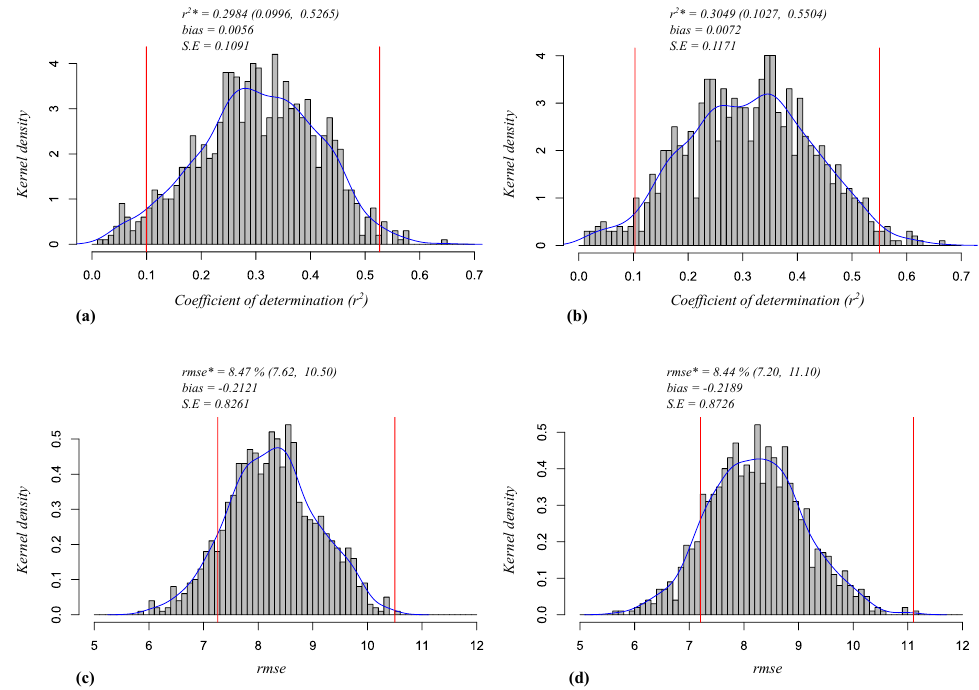
Figure 9. Bootstrap regression model performance based on 1000 bootstrap samples: ( a , b ) Histogram of the bootstrap coefficient of determination for model A and B, respectively. ( c , d ) Histogram of the bootstrap RMSE for model A and B, respectively. The blue lines represent the density plot by Gaussian Kernel smoothing, and the red lines indicate the 95% Confidence Interval (CI) of the mean r 2 ∗ (95% CI) and mean RMSE ∗ (95%